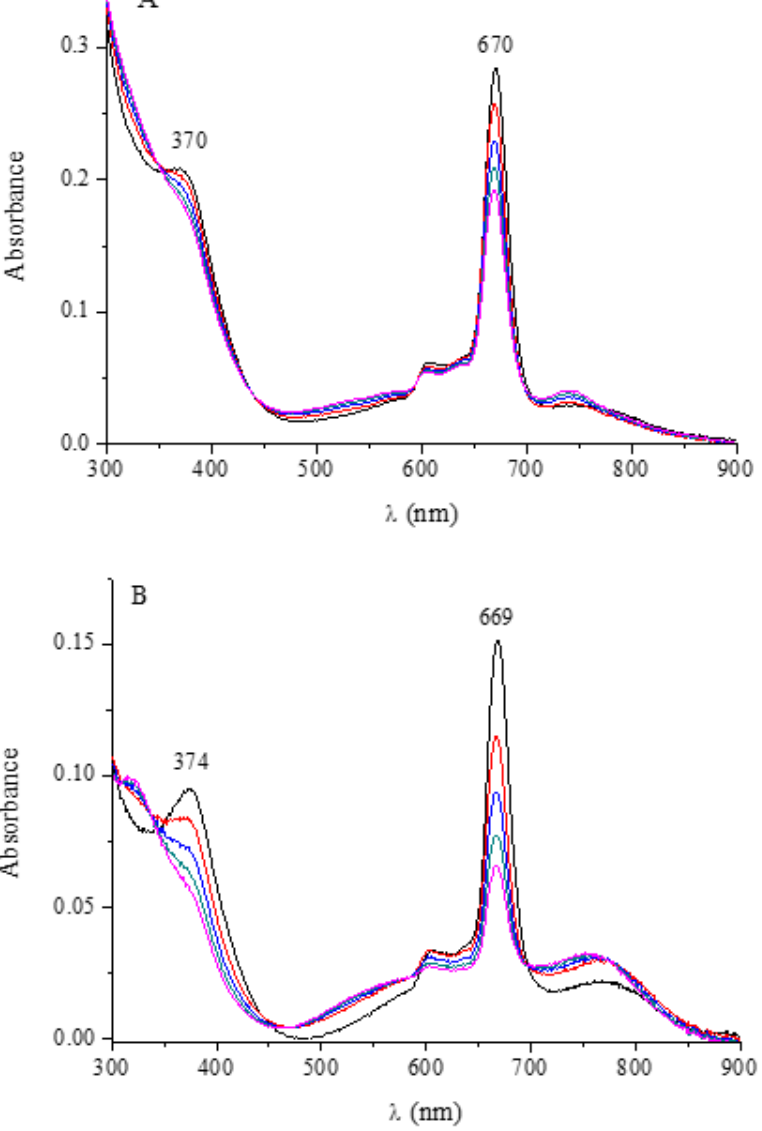
Figure 11. UV-visible spectra in the range 300–900 nm of [(PdCl 2 ) 4 Py 8 TPyzPzIn(OAc)]·8H 2 O ( A) and and [(PtCl 2 ) 4 Py 8 TPyzPzIn(OAc)] · H 2 O ( B ) in DMSO. [(PtCl 2 ) 4 Py 8 TPyzPzIn(OAc)]·H 2 O (B ) in DMSO. [{Pd(CBT) 2 } 4 Py 8 TPyzPzIn(OAc)] ∙ 19H 2 O (CBT = m- carborane-1-thiolate anion) . In [(PdCl 2 ) 4 Py 8 TPyzPzIn(OAc)] · 8H 2 O with m- carborane-1-thiol (Section 2), this